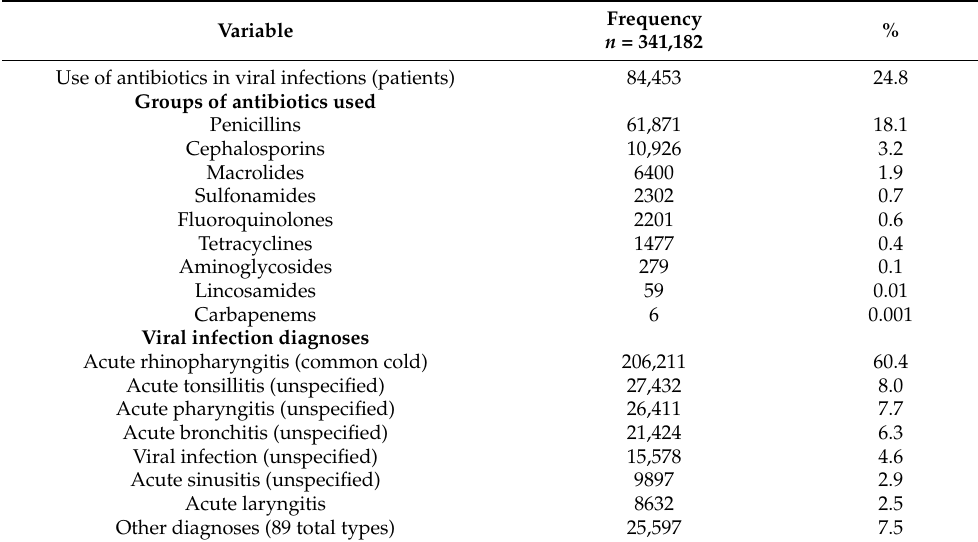
Table 2. Most frequent diagnoses and groups of antibiotics prescribed for patients with viral respira- tory tract infections, Colombia—2018.